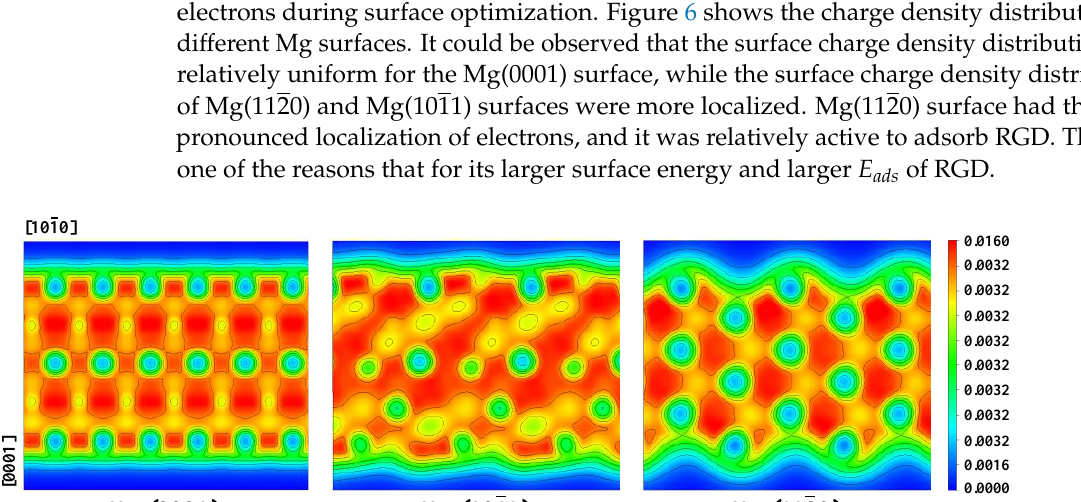
Mg and Mg alloy surfaces, respectively.